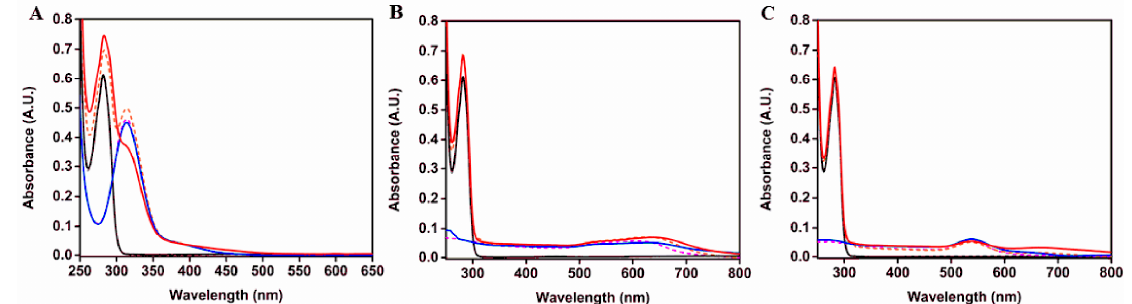
Figure 3. UV-VIS spectra, fresh solutions and after 4 h of: VAN 0.1 mM (dotted grey and black), Au species (( A ) HAuCl 4 0.1 mM, ( B ) AuNPs 50 nm and ( C ) AuNPs 15 nm) (dotted pink and blue), and mixture of VAN 0.1 mM and Au species (( A ) HAuCl 4 0.1 mM, ( B ) AuNPs 50 nm and ( C ) AuNPs 15 nm) (dotted orange and red).